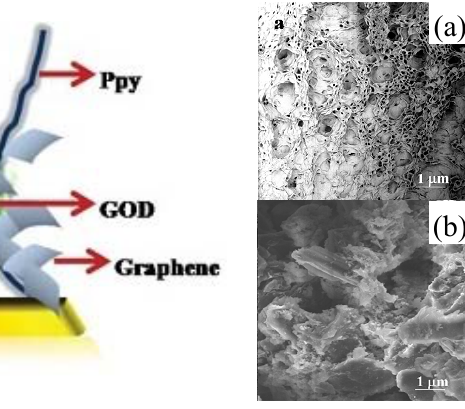
Figure 9. Schematic diagram of Graphene-GOD entrapped within a porous Ppy matrix, the insert ( a ) is the SEM image of porous structure of electropolymerized Ppy; and ( b ) SEM image of Graphene-GOD on the electrode surface. Reprinted with the permission from